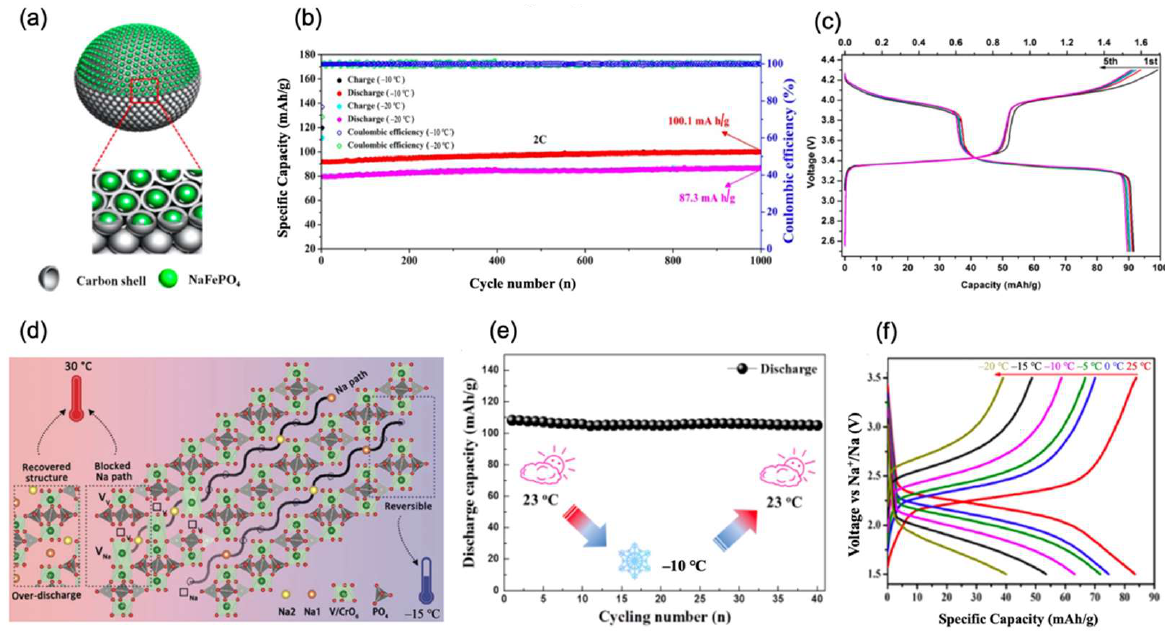
Figure 3. ( a ) The structure of the NFP@C. ( b ) NFP@C cathode charge–discharge in long-term cy-